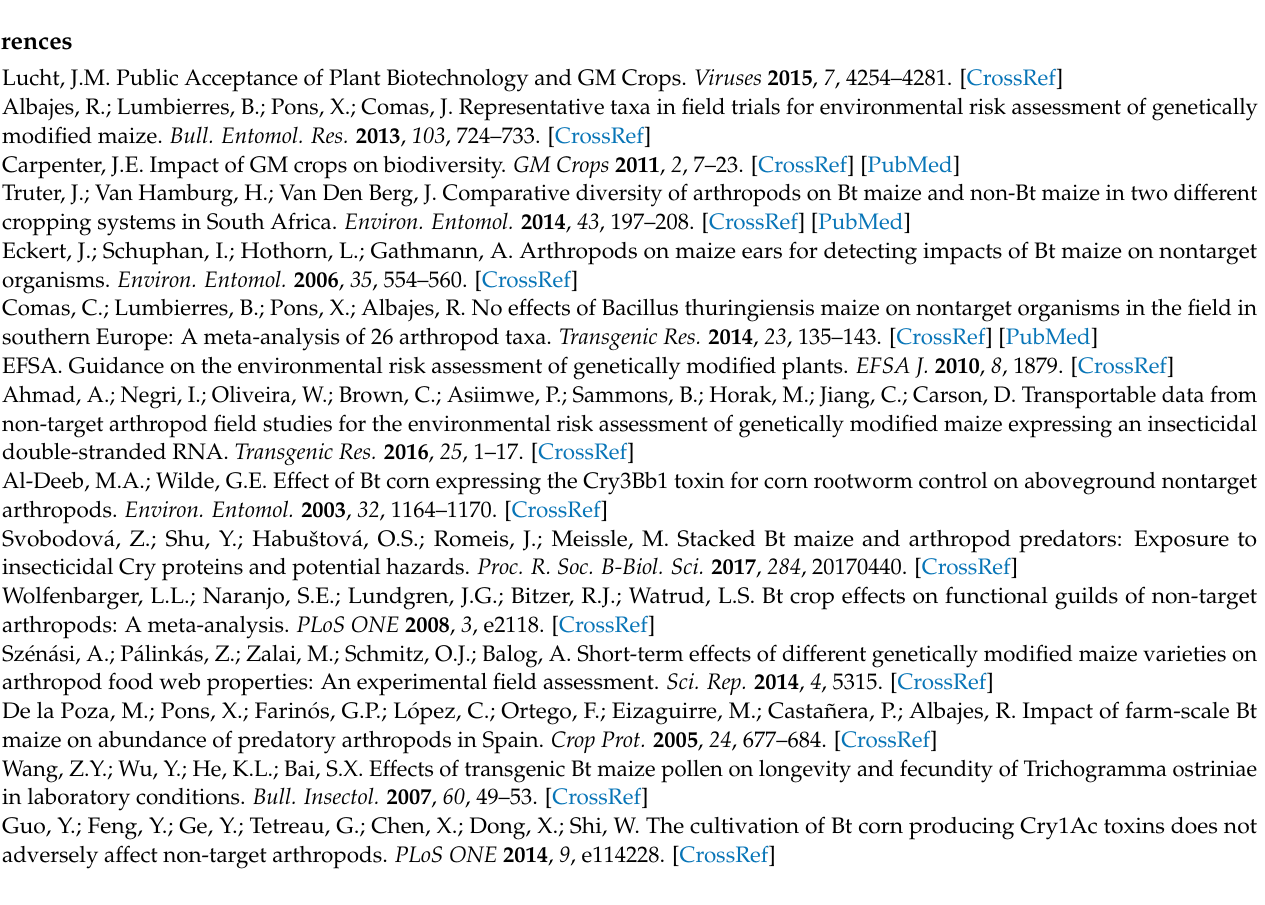
Table S2: Orders, family and parts of identified patterns of the arthropod community in maize field, Table S3: From 2015 to 2017, the cumulative number of main arthropod groups in the field of cultivated variety XianYu335 (XY), non-transgenic recipient variety DBN318 (NT), transgenic maize DBN9868 (T1) and DBN9936 (T2), Table S4: The expression levels of Cry1Ab, EPSPS and PAT proteins in maize materials determined by ELISA ( µ g/g · dwt), Figure S1: From 2015 to 2017, Dynamic of Pielou evenness index ( J ) of arthropod community in the fields of cultivated variety XianYu335 (XY), Figure S2: From 2015 to 2017, Dynamic of the dominance index ( C ) of arthropod communities in the fields of cultivated variety XianYu335 (XY), non-transgenic recipient variety DBN318 (NT), transgenic maize DBN9868 (T1) and DBN9936 (T2), Figure S3: Plots design in